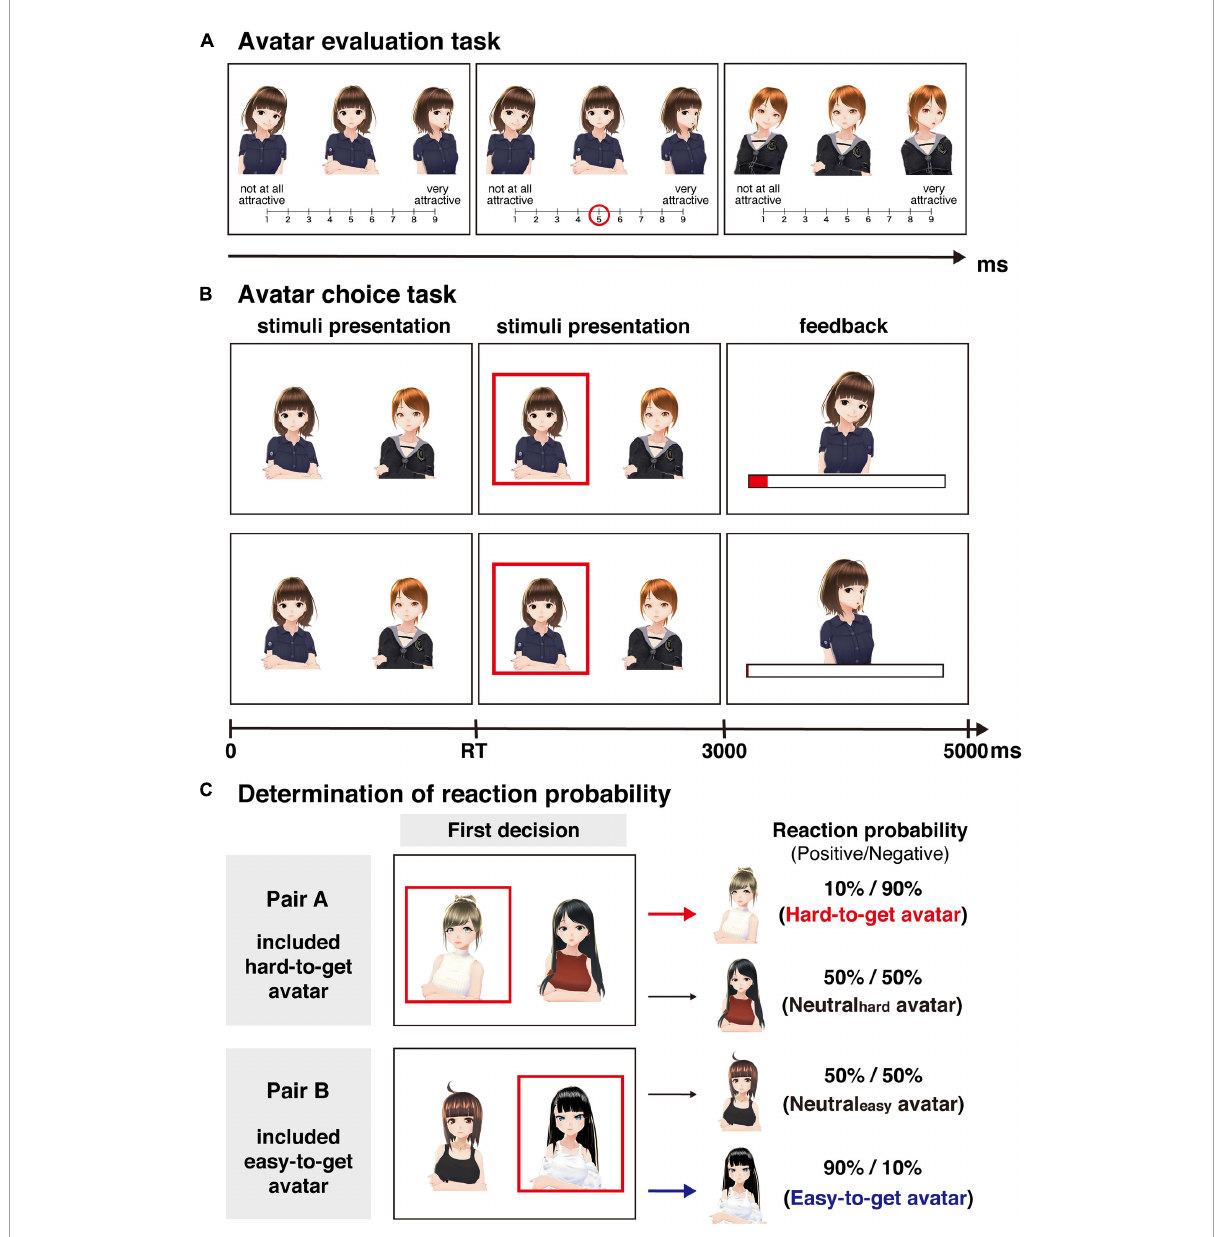
FIGURE1 Behavioral tasks. (A) Avatar evaluation task. Participants were asked to rate the attractiveness of 48 avatars on a 9-point scale. (B) Avatar choice task. This task required participants to choose one of the two avatars displayed on the screen and to maximize the extent to which the avatar liked them, represented as a length of red bar. After they chose an avatar (RT is response time), the reaction from the chosen avatar was displayed. The upper line represents the flow of the task with a positive avatar reaction, while the lower line represents the flow of the task with a negative avatar reaction. Positive reactions increase likeability, while negative reactions do not alter likeability. (C) The outcome probability for each avatar was determined based on the first choice in the avatar choice task. In pair A, the initially chosen avatar was rarely associated with positive reactions in subsequent trials (positive/negative = 0.1/0.9; i.e., hard-to-get avatar). On the other hand, the initially chosen avatar in pair B was frequently associated with positive reactions in subsequent trials (positive/negative = 0.9/0.1; i.e., easy-to-get avatar). Avatar images reproduced with permission from Pixiv